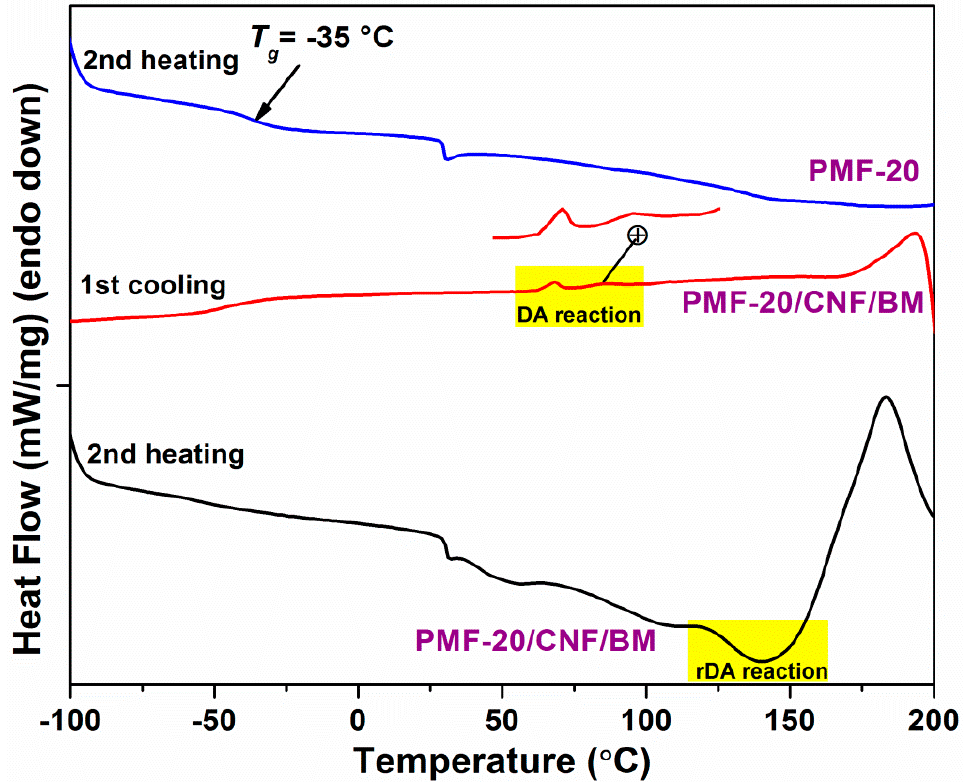
Figure 10. DSC plot of pristine PMF-20 and PMF/CNFs/BM DA-crosslinked adduct.